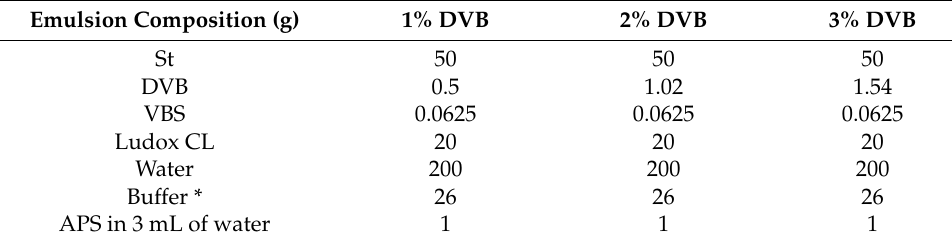
Table 1. Composition of the